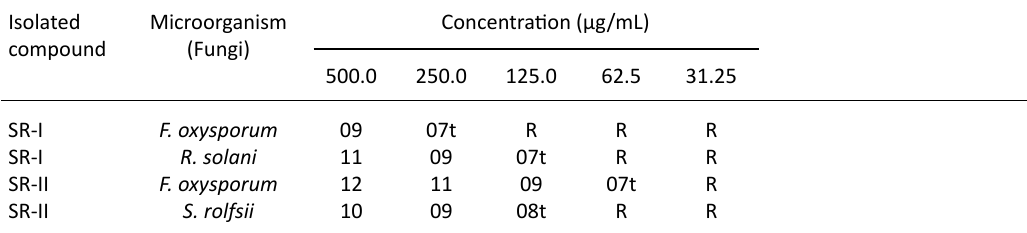
Table 4. The MIC data of different isolated compounds Isolated Microorganism Concentration (µg/mL)